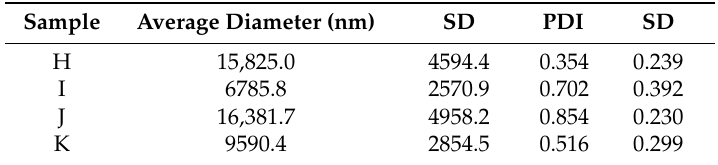
Table 2. The average results for the particle diameter in the sample and polydispersity index (PDI) value along with the standard deviation (SD).